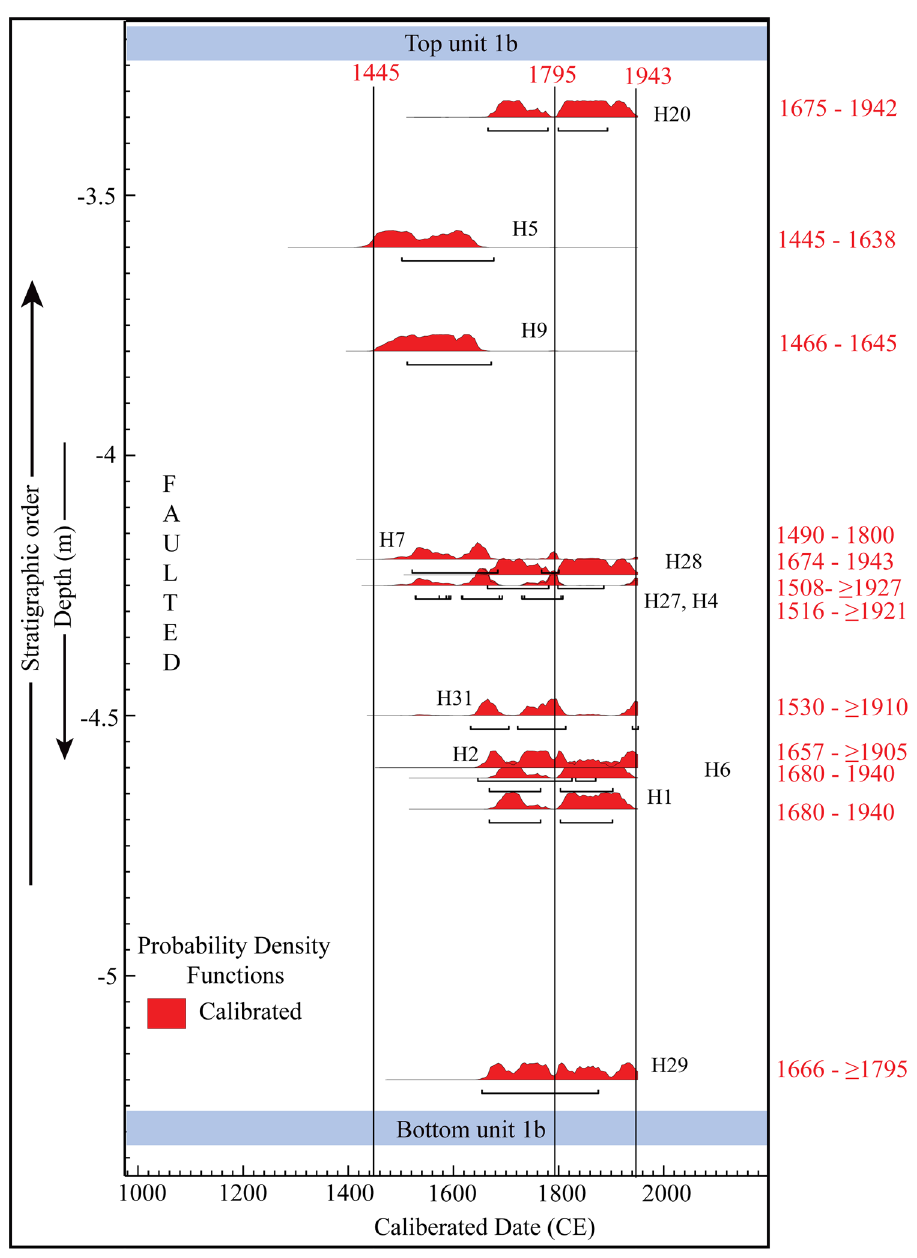
Figure 5. Probability density function (PDF) plot of radiocarbon samples obtained from the Himebasti trench exposure plotted in an age-depth model showing span of calendar ages. Plot generated in Ox-Cal v4.4.2 (https ://14C.arch.ox.ac.uk/oxcal /OxCal .html) 21 with the IntCal13 atmospheric curve of Reimer et al. 52 . Artwork was performed in the Adobe Illustrator